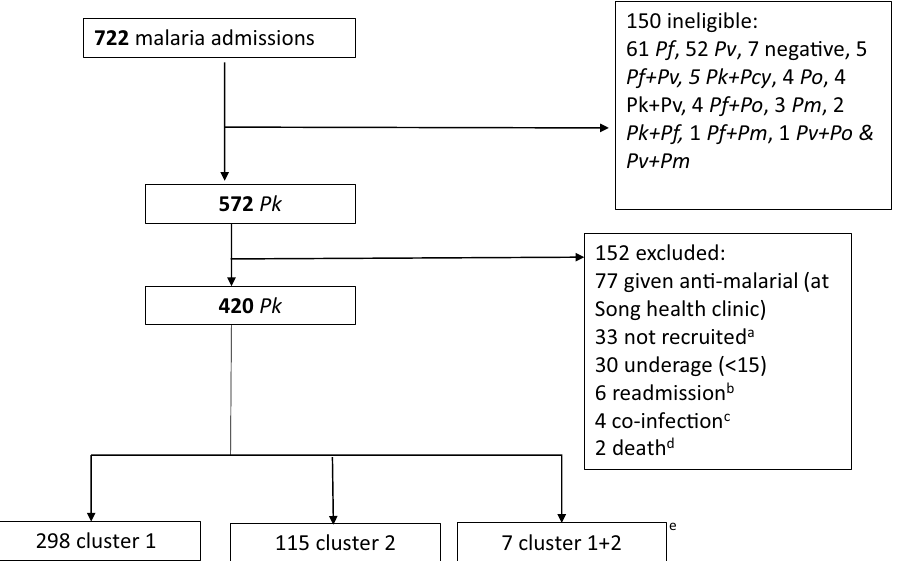
Figure 1. Recruitment flow chart of patients at Kapit Hospital from 27th Sept 2016 until 12th Oct 2018. a Patients not recruited since study clinicians not working and/or not informed (33), b Only index cases were recruited, c Other concurrent infections such as active tuberculosis (n = 1), leptospirosis (n = 2) and dengue positive by rapid diagnostic test (n = 1) and d Not recruited; PCR analysis not done for one patient who was identified posthumously as P. knowlesi by microscopy while another was identified as P. knowlesi after transfer to a tertiary hospital (patient’s sample obtained and subsequently identified by PCR). e Patients with both cluster 1 and cluster 2 infections. Pk = P. knowlesi ; Pm = P. malariae ; Pf = P. falciparum , Pv = P. vivax , Po = P. ovale .